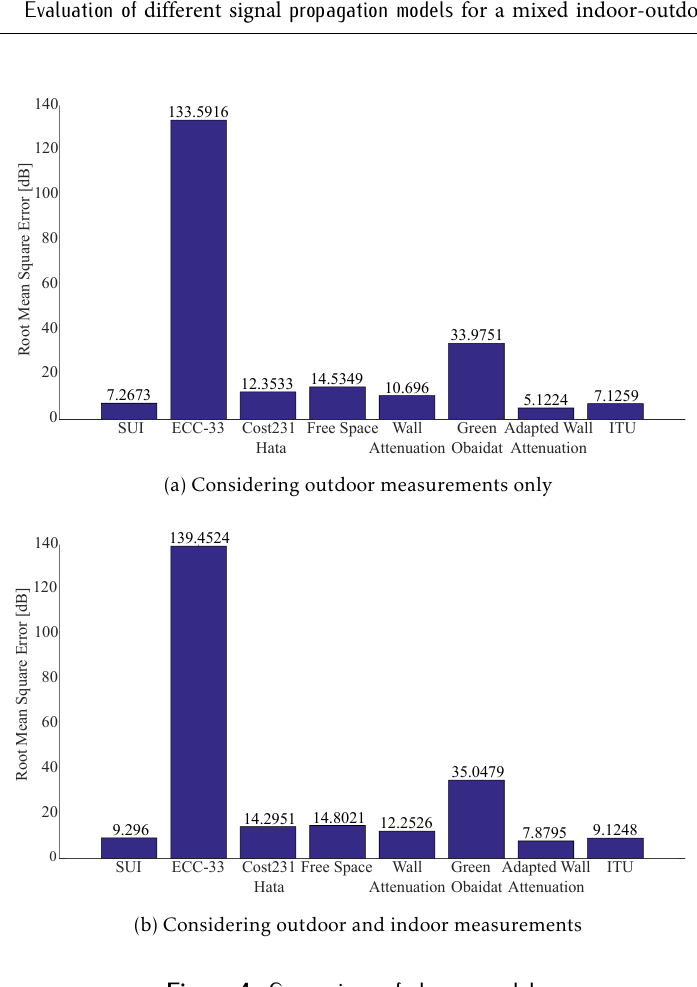
Figure 4. Comparison of chosen models. Table 5. Propagation parameters for the